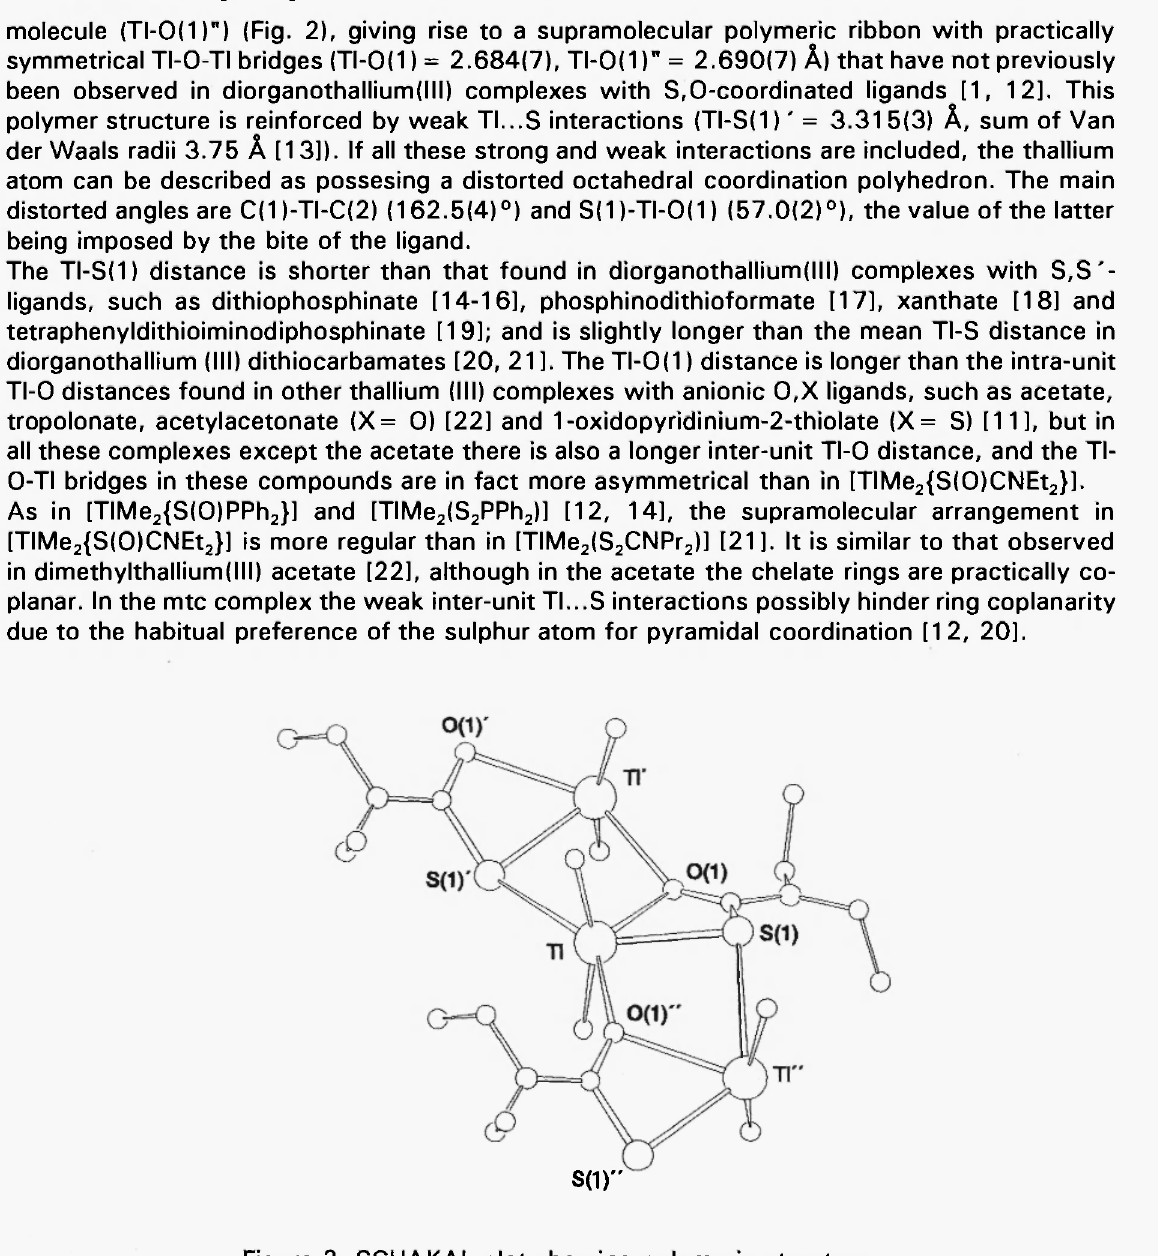
Figure 2. SCHAKAL plot showing polymeric structure in [TIMe 2 {S(0)CNEt 2